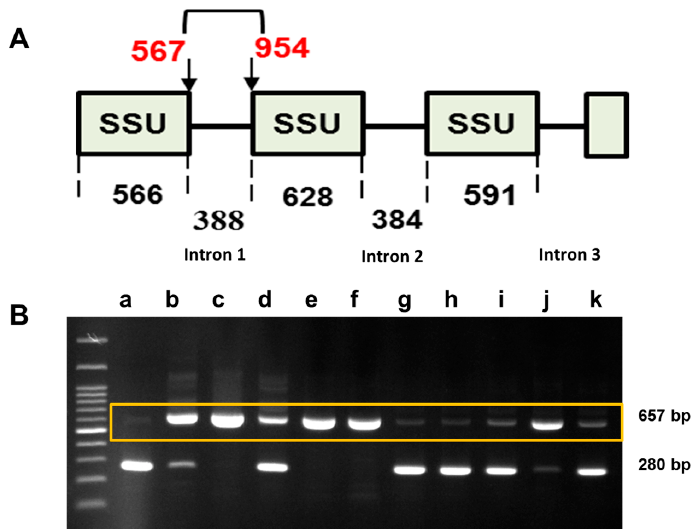
Figure 3. Variability in intron 1 of the small subunit (SSU) of the ribosomal DNA of P. brassicae . Numbers indicate the size of the SSUs and intron positions. Numbers in the figure are lengths in bp of each subunit and intron. ( A ) Schematic structure of the SSUs; red letters indicate the position of intron 1; ( B ) A deletion (388 bp; Figure S3) was detected in the a, g, h, i, and k isolates. a,